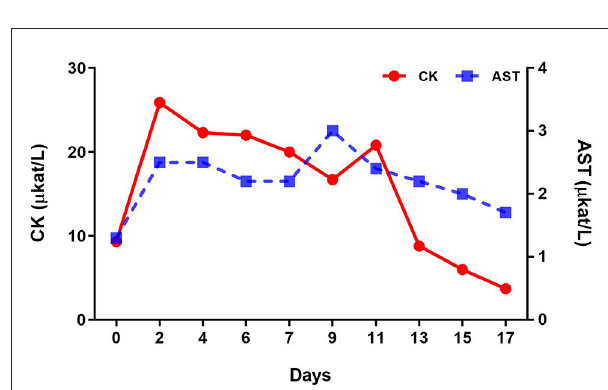
FIGURE3 Changes in creatine kinase (CK) and aspartate aminotransferase (AST) levels after the onset of tetanus and during treatment.